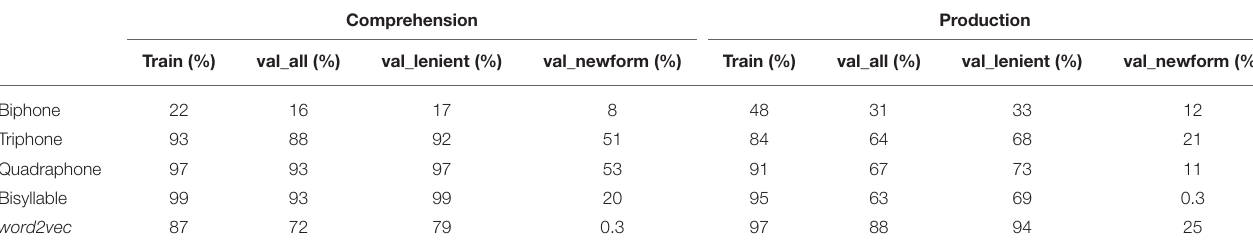
TABLE 5 | Comprehension and production accuracy for train and validation datasets, with biphones, triphones, quadraphones, and bisyllables as cues.